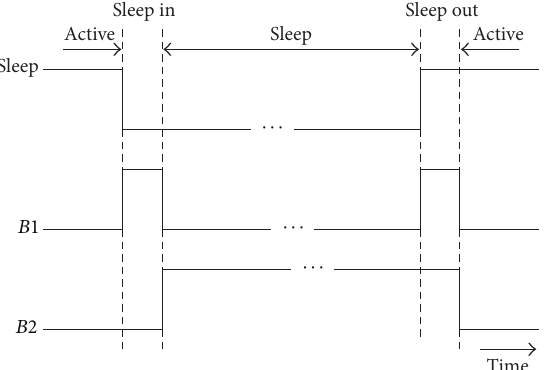
Figure 3: Sequence of the control signals for the Balloon-FF circuit.